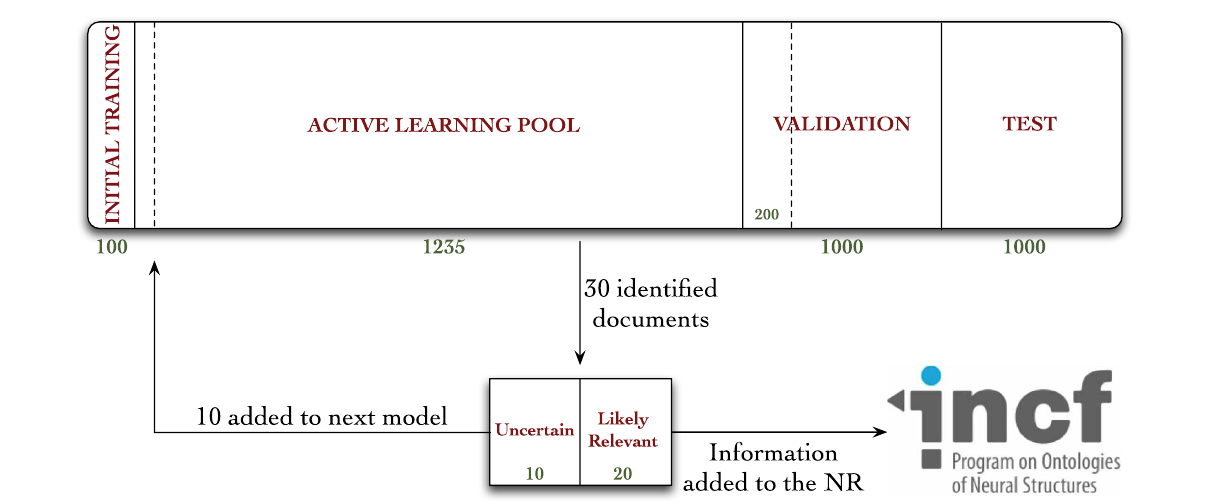
of 962 documents were annotated during these experiments—670 during the active learning procedure, 92 during the random validation experiments, and an additional 200 for the hold-out test collection, used to evaluate the Virk system against the random